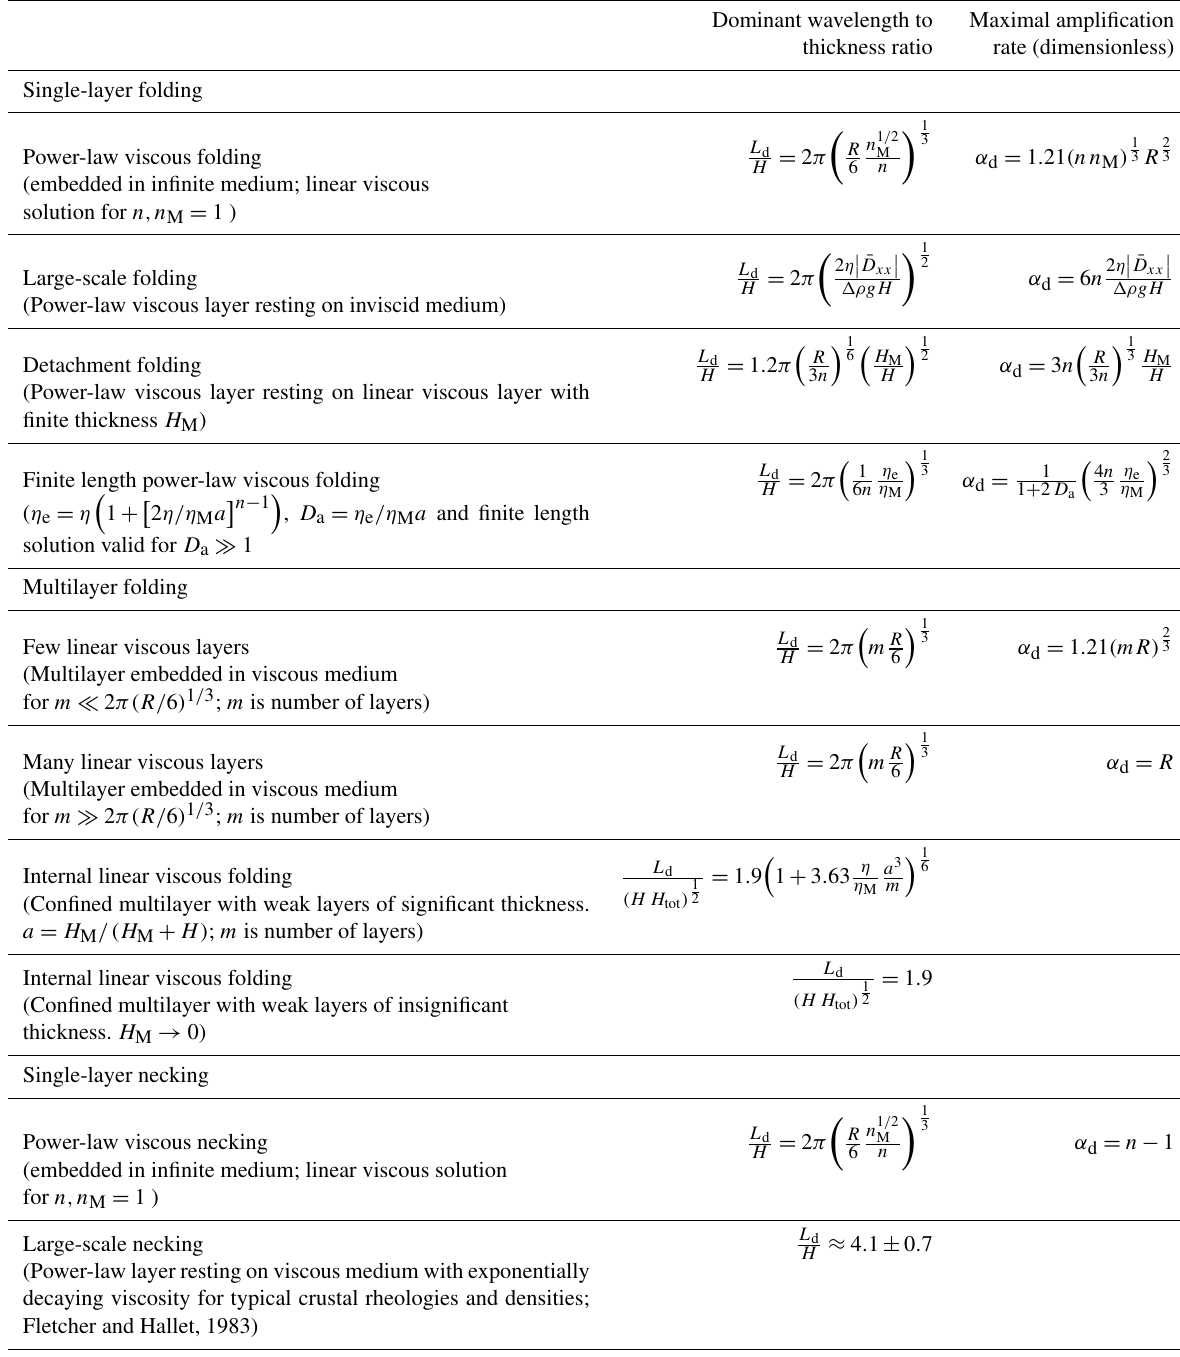
Table 2. Approximate solutions for dominant wavelength and maximal amplification rates for folding and